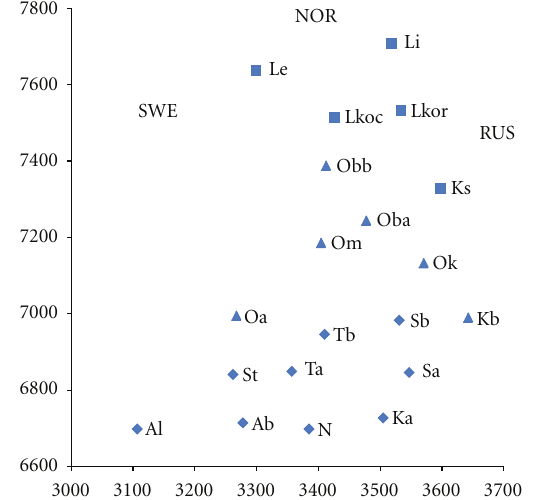
Figure 1: Schematic view of Finland, showing the location of biogeographical provinces (see Table 1 for abbreviations). Squares represent north boreal, triangels middle boreal and diamonds hemi and south boreal ecoregions. North co-ordinates are kilometers from the Equator. SWE = Sweden, NOR = Norway, RUS =